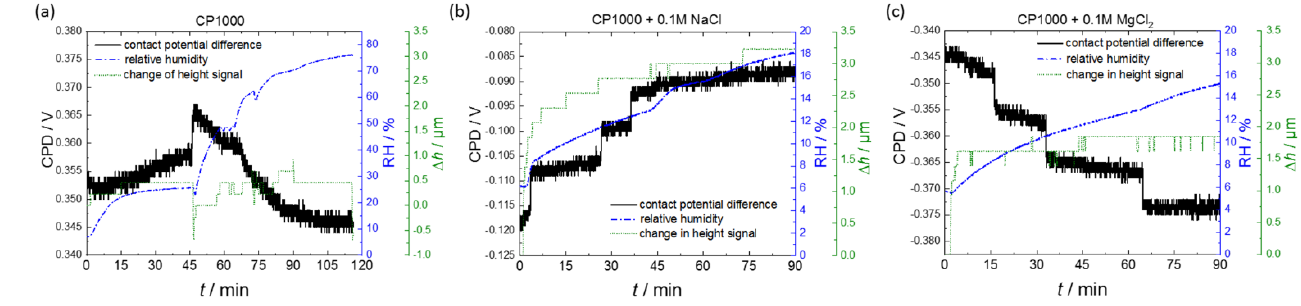
Figure 9. Evolution of CPD and change in height signal measured by SKP during increase in RH on ( a ) clean CP1000 surface, as well as CP1000 with addition of ( b ) 0.1 M NaCl and ( c ) 0.1 M MgCl 2 solution.